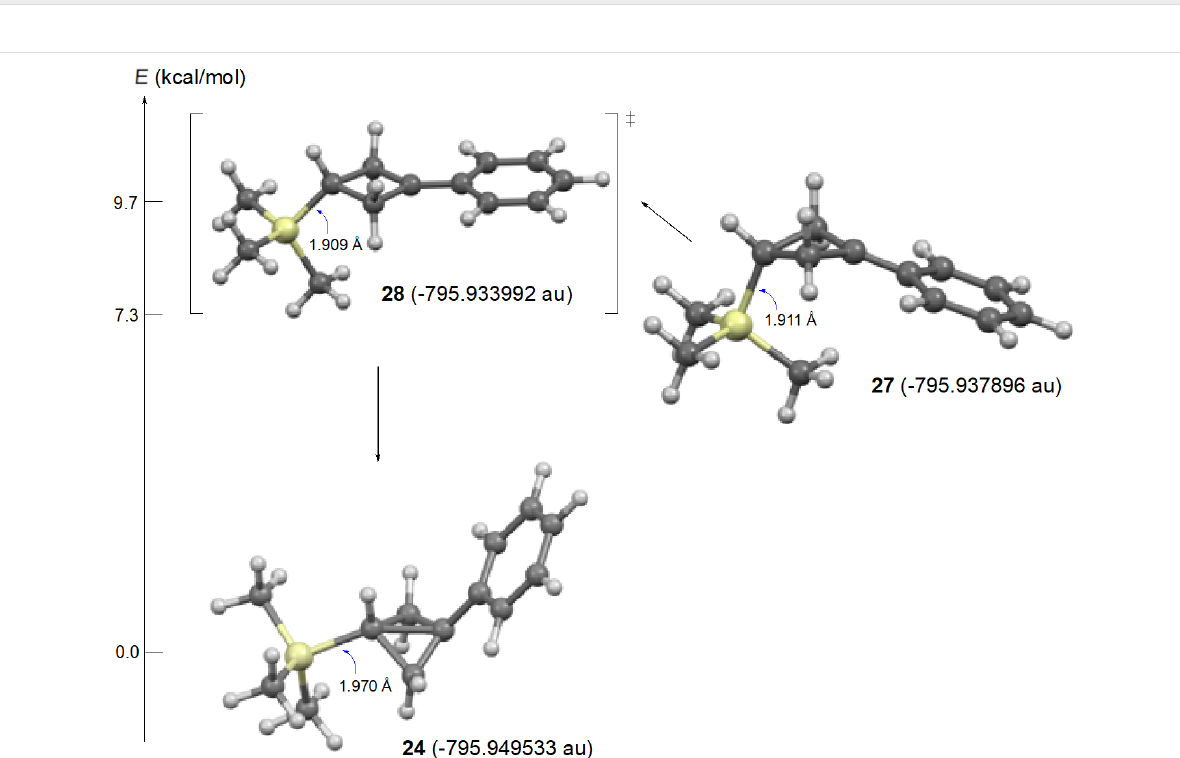
Figure 3: M062X/6-311+G** calculated structures and relative energies of cations 24 , 27 , and transition state 28